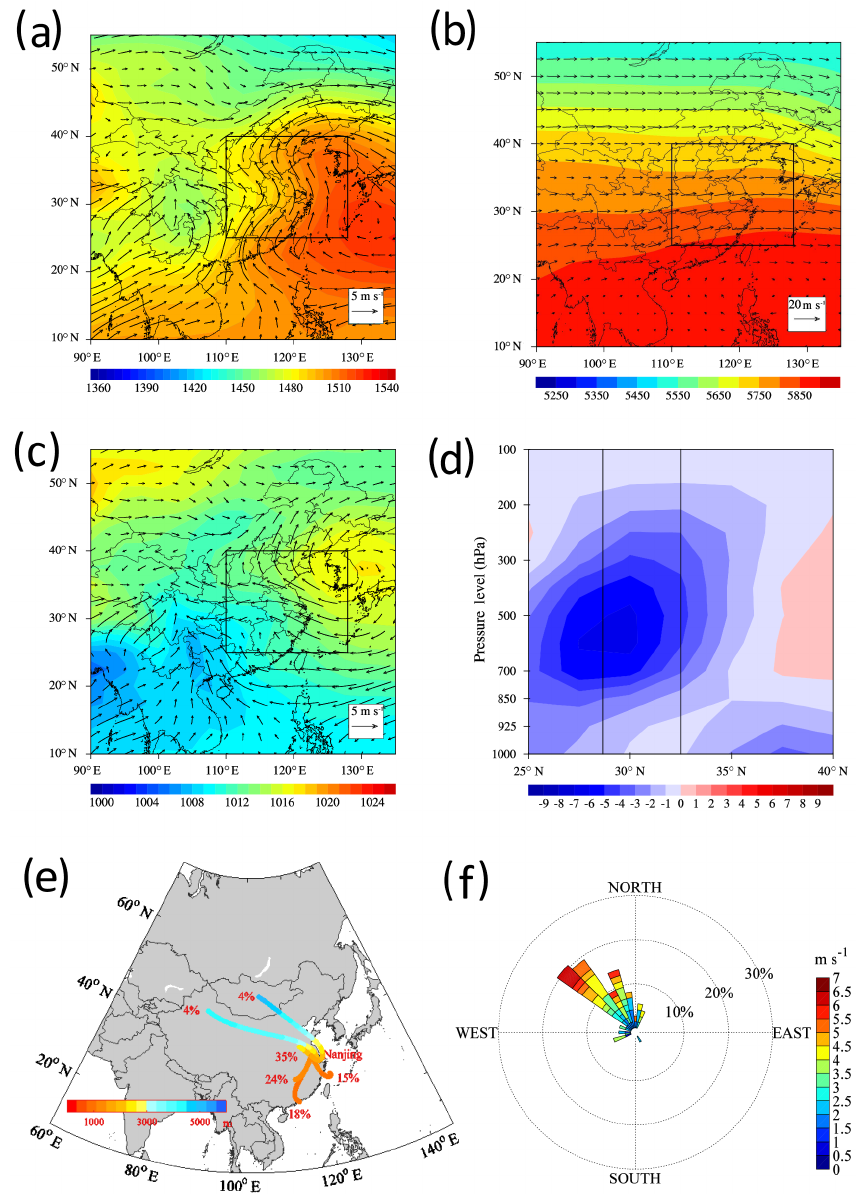
Figure 8. As in Fig. 7, but for Pattern